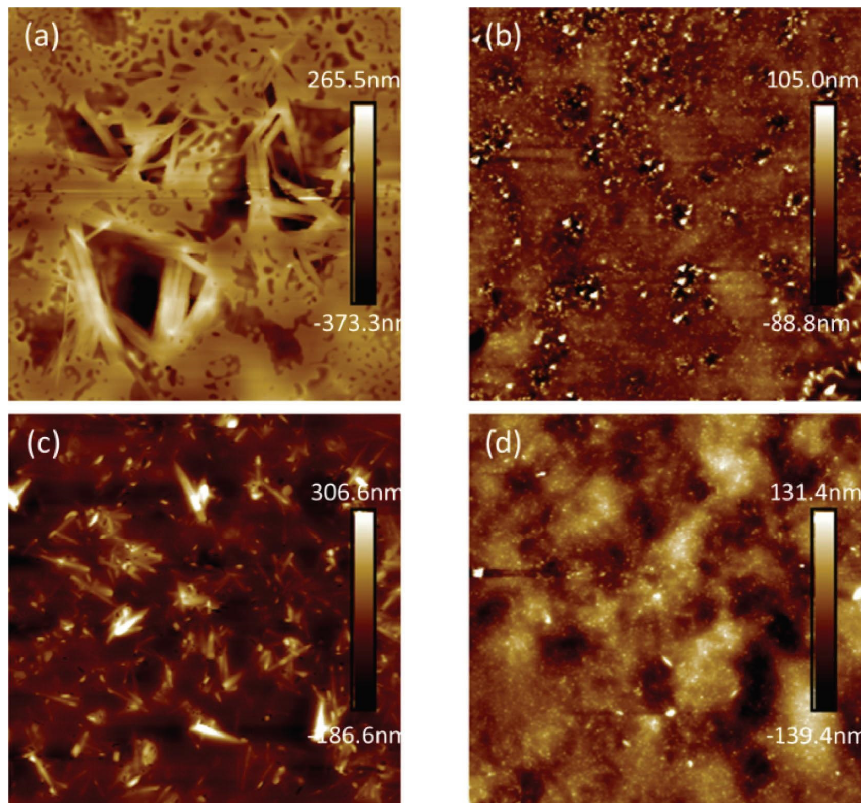
Figure 13: AFM images of T622 modifed asphalt. (a) 76.25h. (b) 152.5h. (c) 228h. (d)